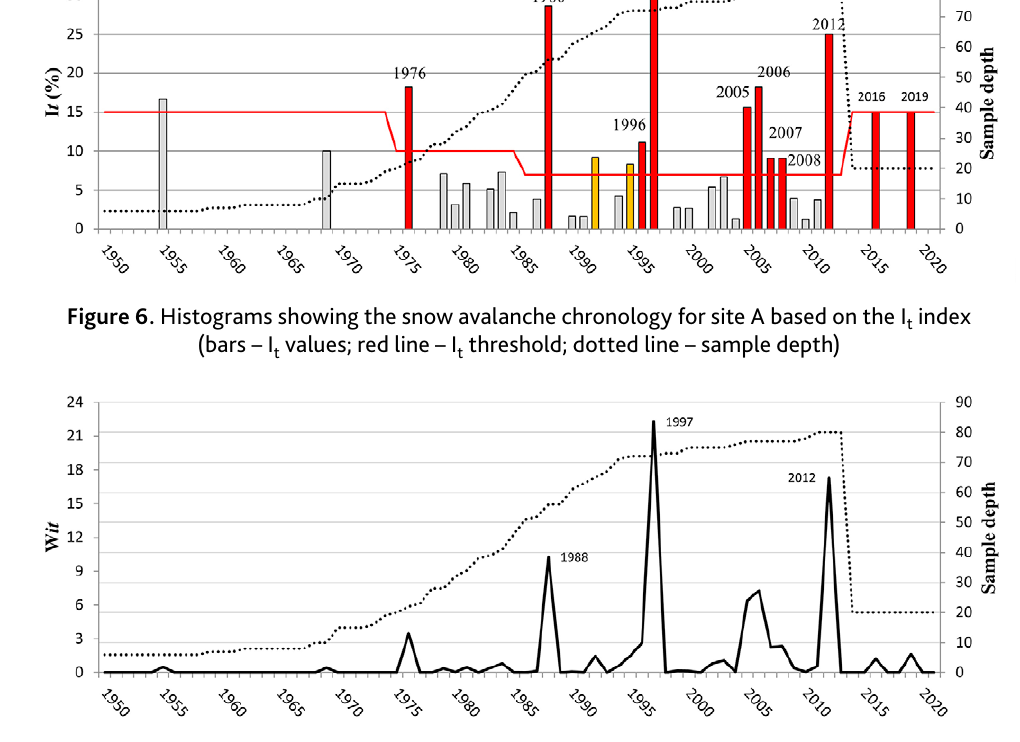
Figure 7. Histogram showing the dendrochronological signal strength for site A based on the reaction intensity (W